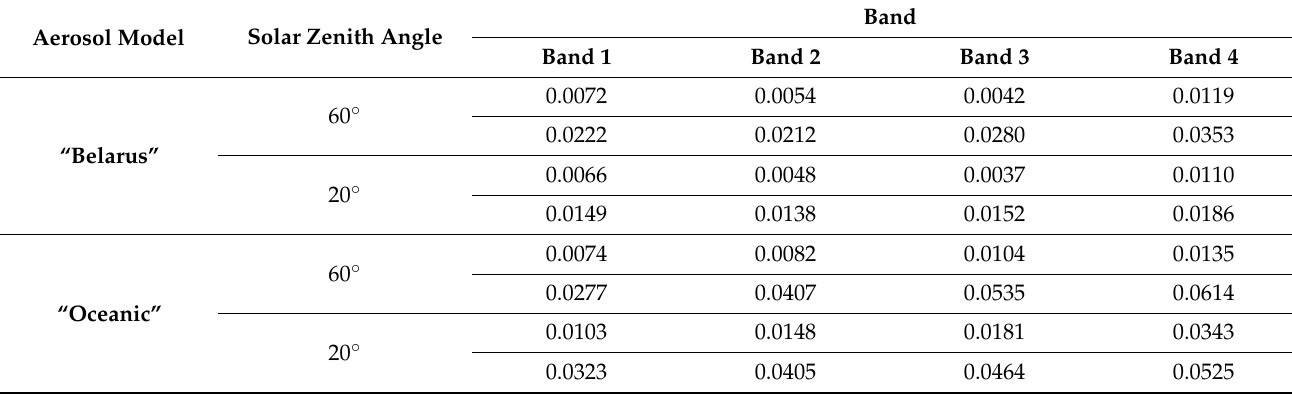
Table 11. RMSE of reflectance retrieval for dark surfaces (upper numbers) and bright surfaces (lower numbers) in the MZ spectral channels in the cases of “Belarus” and “Oceanic” models as a “real” atmospheric